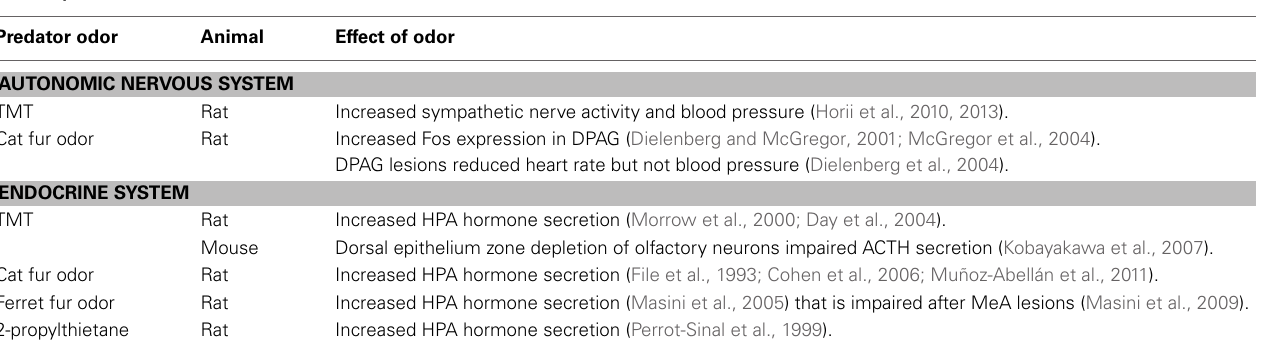
Table 2 | Effects of predator odor on autonomic and endocrine functions. Predator